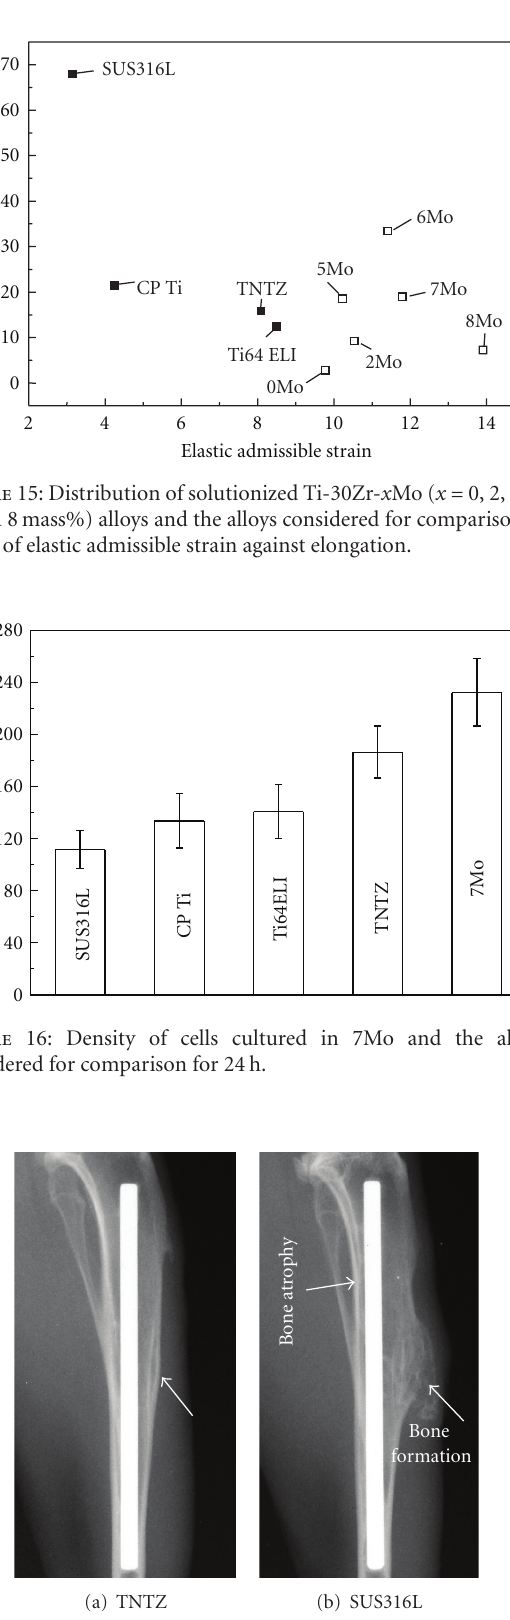
Figure 17: X-ray photographs of intramedullary rods made of (a) TNTZ and (b) SUS316L stainless steel at 24 weeks after implantation into tibiae of